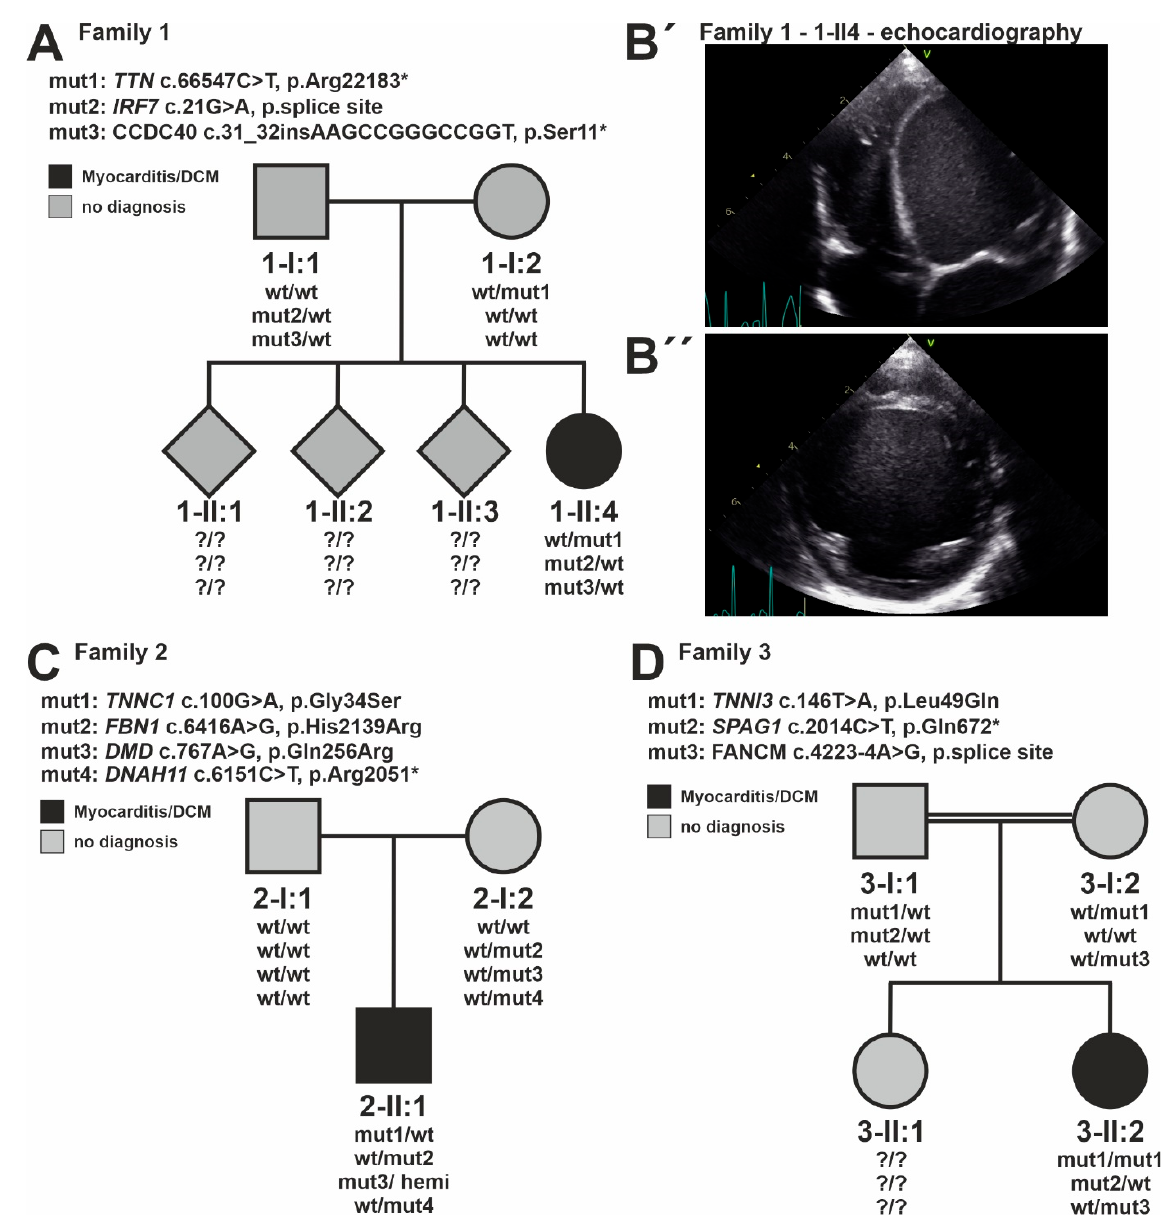
Figure 2. Clinical and genetic evaluation of three selected families with CMP and myocarditis. ( A ) Pedigree of family #1 with the index patient 1-II:4 carrying a heterozygous titin truncating variant ( TTN -tv), a splice variant in interferon regulatory factor 7 ( IRF7 ), and a protein-truncating variant in coiled-coil domain containing 40 ( CCDC40 ). The IRF7 and CCDC40 alleles are inherited from the father, while the TTN -tv allele is of maternal origin. ( B ′ ) Echocardiographic images of 4-chamber